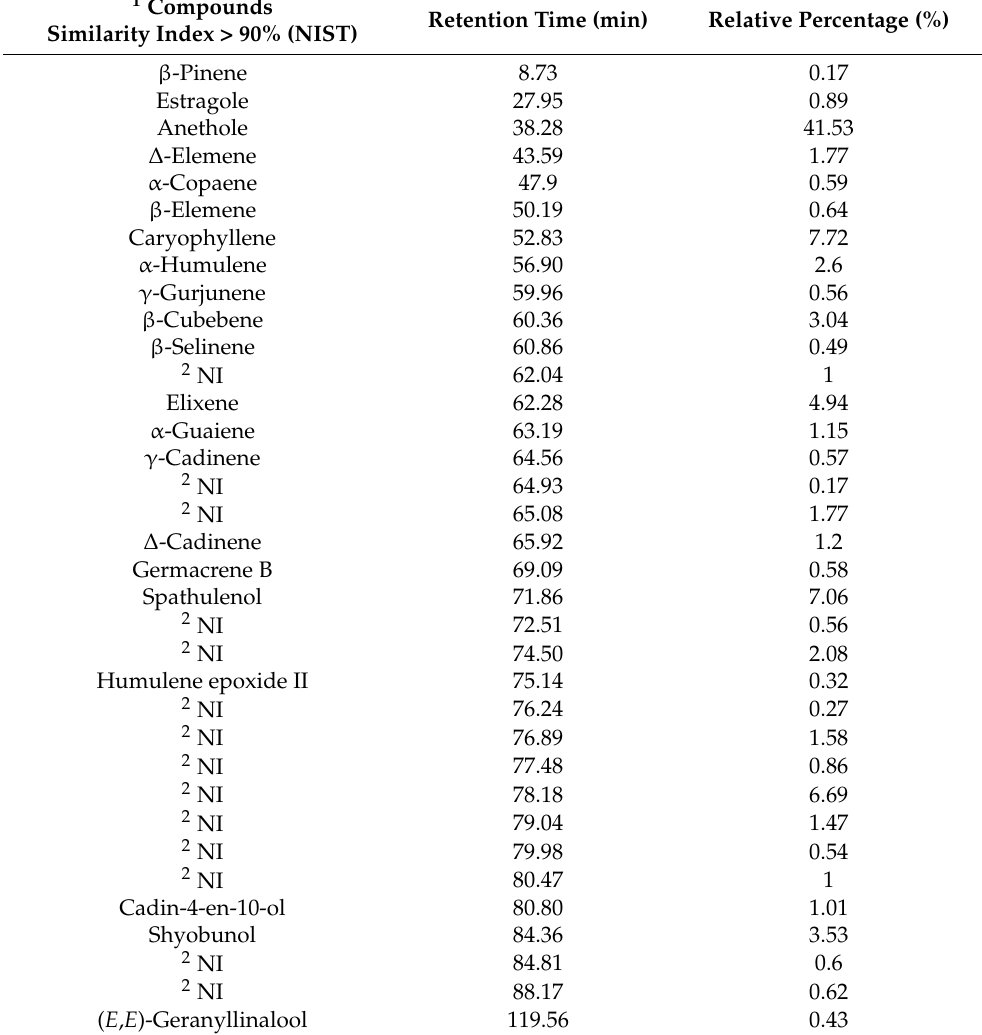
Table 1. GC-MS analysis of V. globosa essential